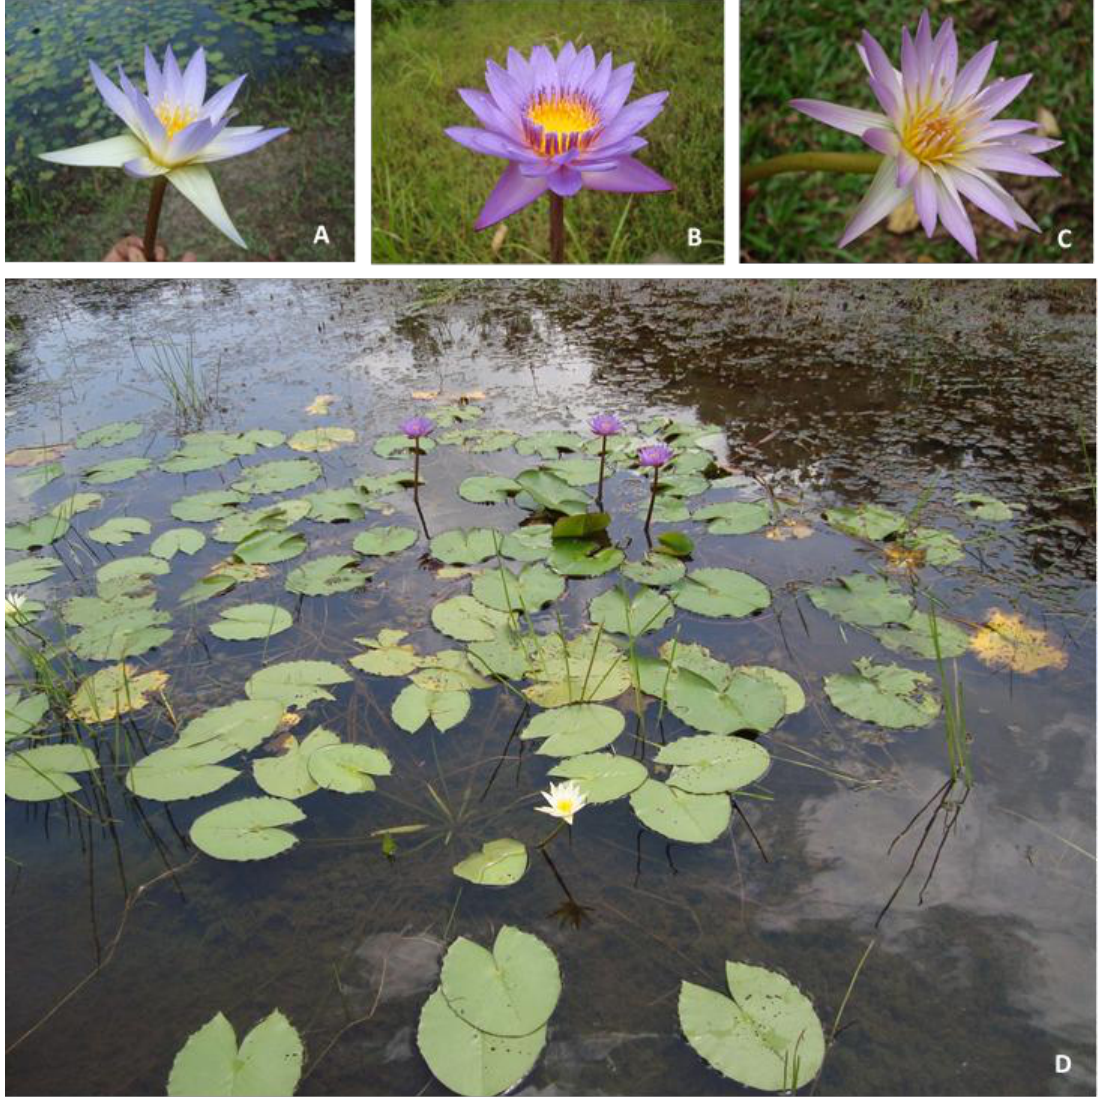
Figure 1: A. Flower of the native Nymphaea nouchali , B. Flower of the exotic violet flowered Nymphaea , C. Flower of Hybrid Nymphaea and D. A mixed population of native and the